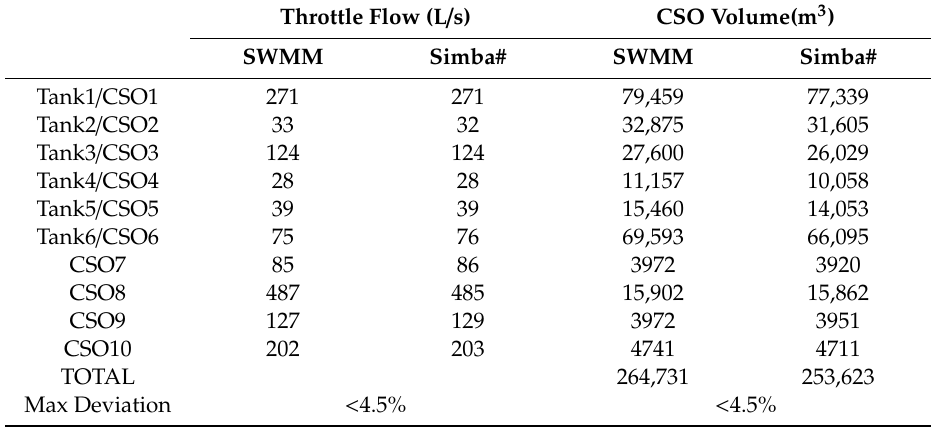
Table 4. Simulated throttle flow (reported as maximum values) and CSO volumes for BC scenario.